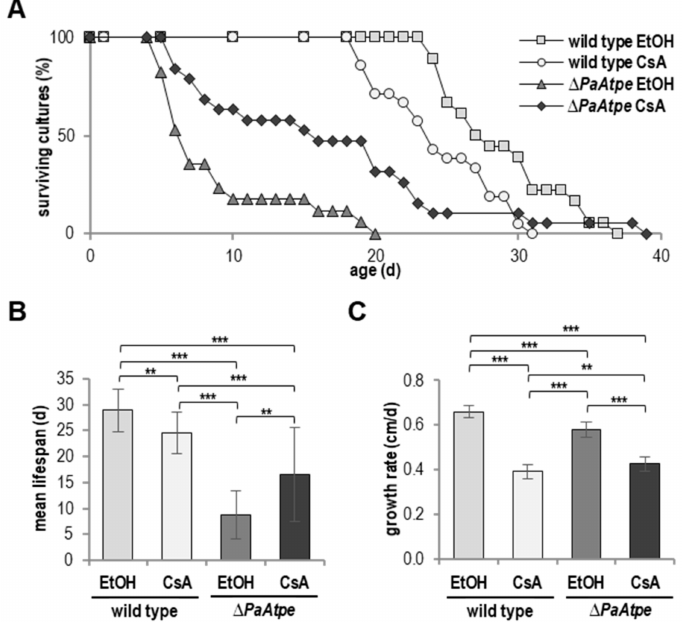
Figure 5. Inhibition of mPTP partially restores lifespan of ∆ PaAtpe . ( A ) Survival curve of P. anserina wild type and ∆ PaAtpe grown on standard M2 medium with ethanol (EtOH) as control or cyclosporine A (CsA) (each 18 biological replicates). ( B ) Mean lifespan and ( C ) mean growth rates of cultures from ( A ). Error bars correspond to the standard deviation. The p -values of the survival curves were determined by SPSS with three different tests and for mean lifespan and growth rate by two-tailed Student’s t test. ** p < 0.01, *** p <